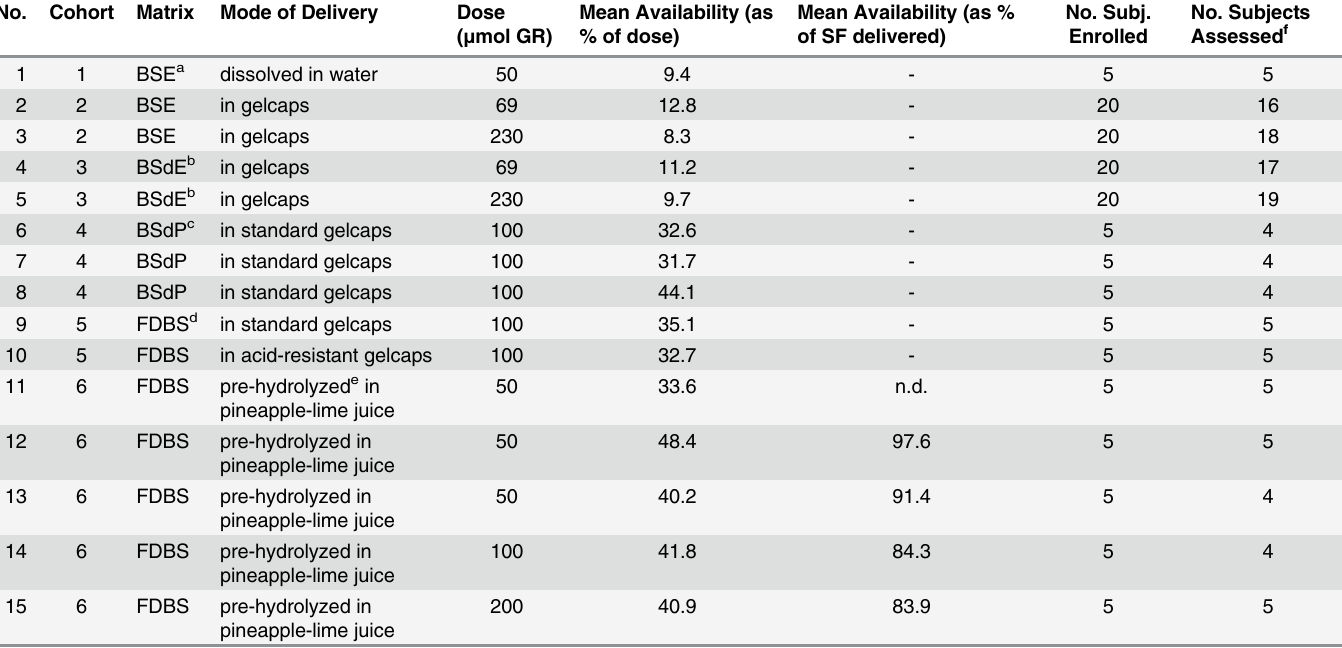
Table 1. Mean bioavailability of sulforaphane from broccoli sprout and seed preparations rich in glucoraphanin, as affected by matrix, mode, of delivery, and activity of myrosinase on its